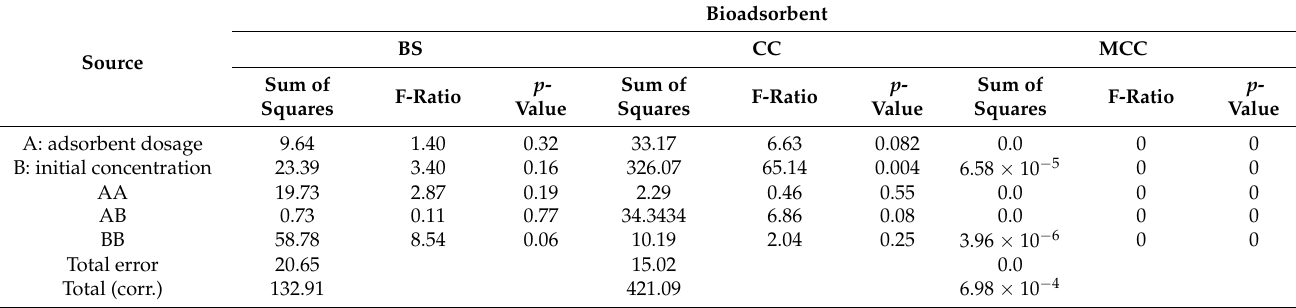
Table 3. ANOVA for the removal efficiency of tartrazine on bioadsorbents prepared from coconut shells.